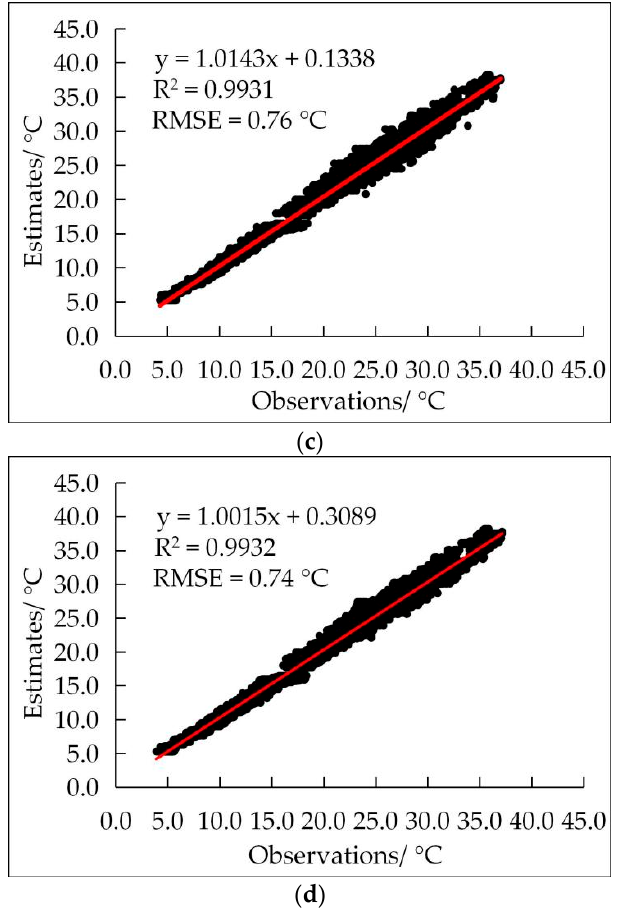
Figure A5. The linear fitting results of the observed and simulated values are reduced by 12 tem- perature sensors. ( a ) Reduced lines 2 and 3; ( b ) Reduced B, C, and D columns; ( c ) Reduced B, C, and E columns; ( d ) Reduced C, D, and E columns.